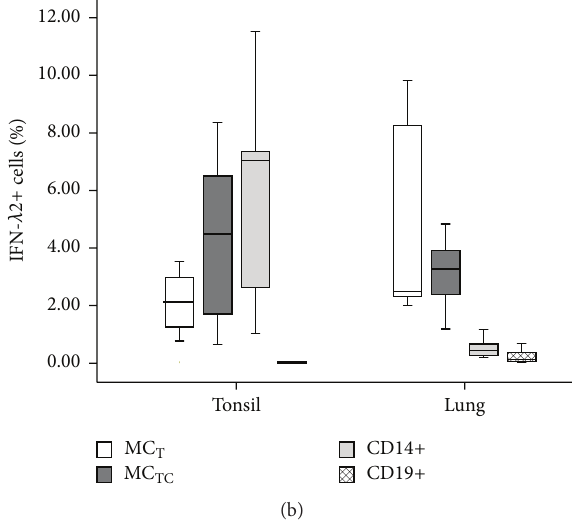
Figure 4: Flow cytometry analysis of expression of IFN- 𝜆 2 in dispersed human MC T , MC TC , CD14+ (macrophages), and CD19+ (B cells) cells. Rabbit anti-human IFN- 𝜆 2 and FITC conjugated goat anti-rabbit IgG antibodies were employed to detect IFN- 𝜆 2 in cells from tonsil and lung, respectively. PE/Cy7-anti-human tryptase (AA5-PE/Cy7), anti-human chymase antibody CC4 (IgM subtype), PE conjugated rat anti-mouse IgM (CC1-PE), PE/Cy7-anti-human CD14 (CD14-PE/Cy7), and APC-anti-human CD19 (CD19-APC) antibodies were used to identify MC T (A), MC TC (B), CD14+ (C), and CD19+ cells (D), respectively. (a) showed representative graphs of flow cytometry analysis. (b) represents boxplot analysis of the expression of IFN- 𝜆 2 in dispersed human MC T , MC TC , CD14+, and CD19+ cells. Data are displayed as a boxplot for 6-7 human tonsil or lung tissues, which indicates the median, the interquartile range, and the largest and smallest values for the number of subjects